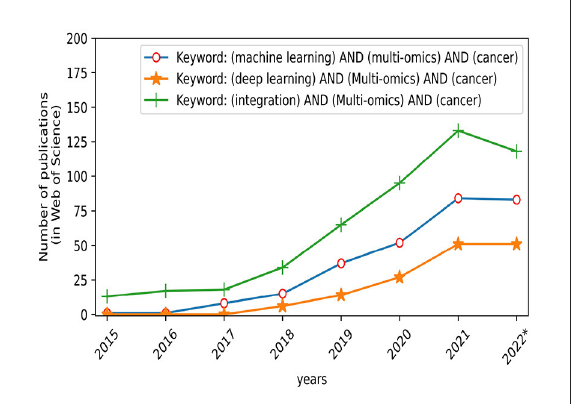
FIGURE1 Number of publications published each year on different search